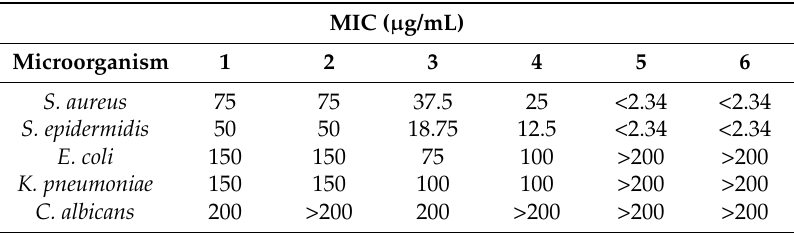
Table 5. Antibiotic activity of compounds 1 – 6 represented as minimal inhibitory concentration (MIC) in µ g/mL. Paulomycin A ( 5 ) and B ( 6 ) were included as